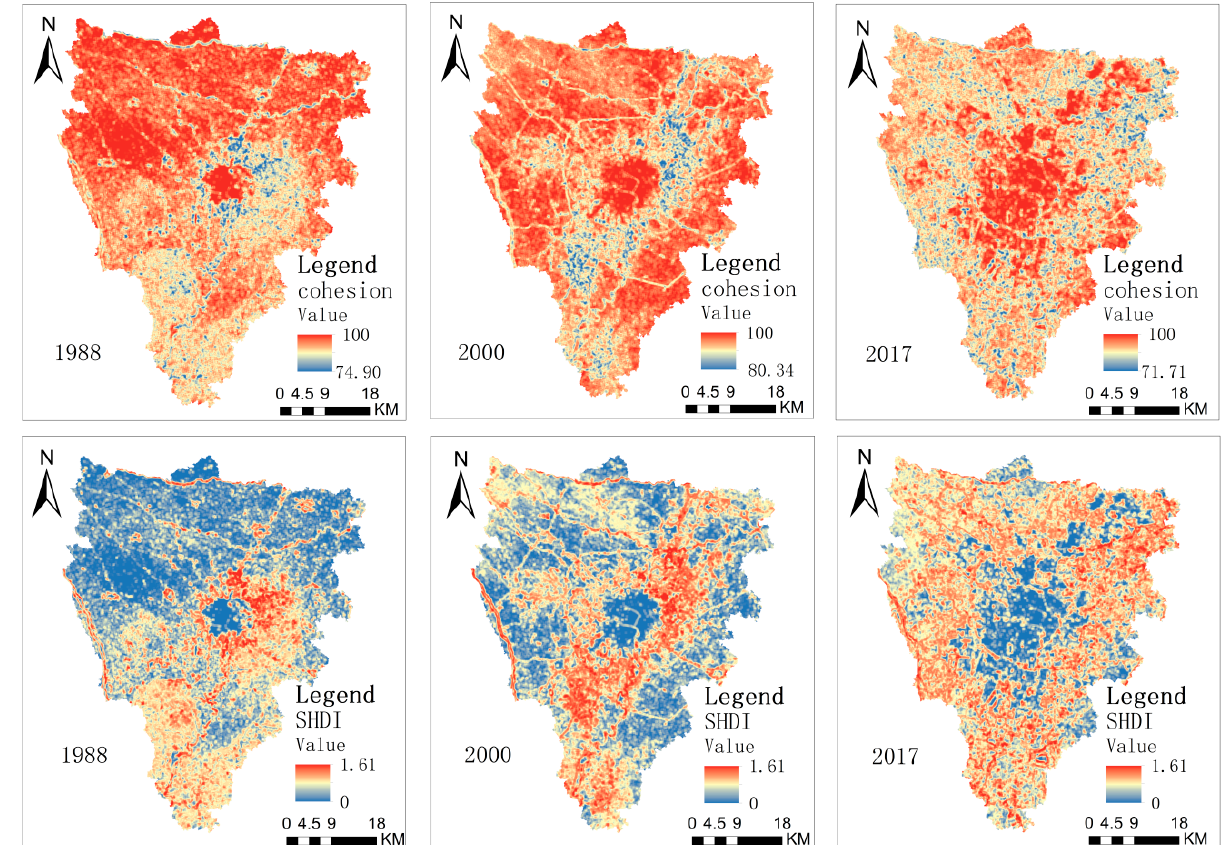
Figure 4. The spatial distribution of landscape index in 1988, 2000, and 2017.